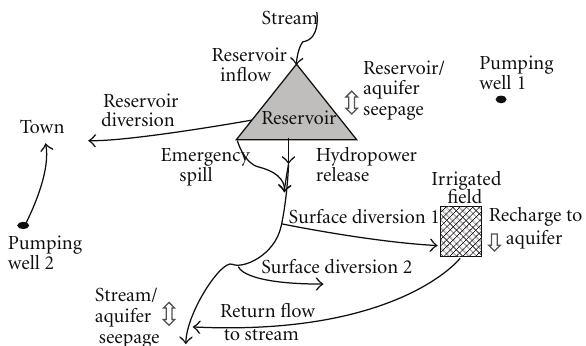
Figure 1: Conceptual view of the hypothetical study area.